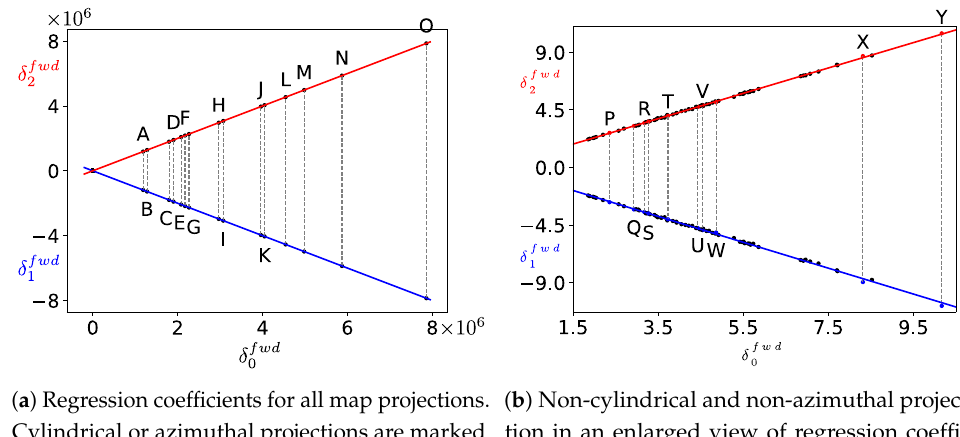
Figure 8. Regression coefficients δ fwd (in black, red, or blue dots), i = 0,1,2, of rational function– i based regression for non-conformal map projections. Capital letters represent rectangular polyconic (A), Lambert equal area conic (B), Patterson cylindrical (C), compact Miller (D), Miller cylindrical (E), Gall stereographic (F), Lambert azimuthal equal area (G), Plate Carrée (H), Albers equal area ( ϕ = 20 ◦ , ϕ = 60 ◦ ) (I), azimuthal equidistant (J), Lambert conformal conic alternative ( ϕ = 40 ◦ ) 2 0 1 (K), equidistant conic ( ϕ 1 = 20 ◦ , ϕ 2 = 60 ◦ ) (L), equal area cylindrical ( ϕ ts = 0 ◦ ) (M), Gall isographic (N), equal area cylindrical ( ϕ ts = 45 ◦ ) (O), Urmaev V (P), Eckert II (Q), general sinusoidal series ( m = 2, n = 3) (R), Urmaev FPS (S), Hatano asymmetrical equal area (T), Nell (U), Tobler–Mercator (V), Bonne ( ϕ 1 = 30 ◦ ) (W), Collignon (X), and Bacon Globular (Y) projections. Table 1. Summary of coefficients for rational function–based regression. Most † Non-Cylindrical, Non-Conic, All Non-Conformal Map Projections in and Non-Azimuthal Projections in Figure 8a Figure